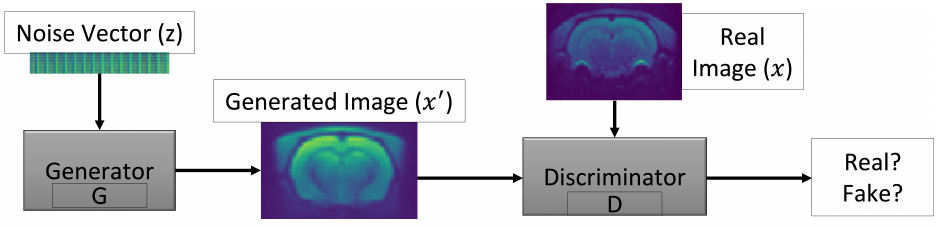
Figure 1. Representation of the basic Generative Adversarial Networks (GANs) architecture with noise vector (z), generator (G), synthetic data ( x (cid:48) ), real data ( x ) and discriminator (D).